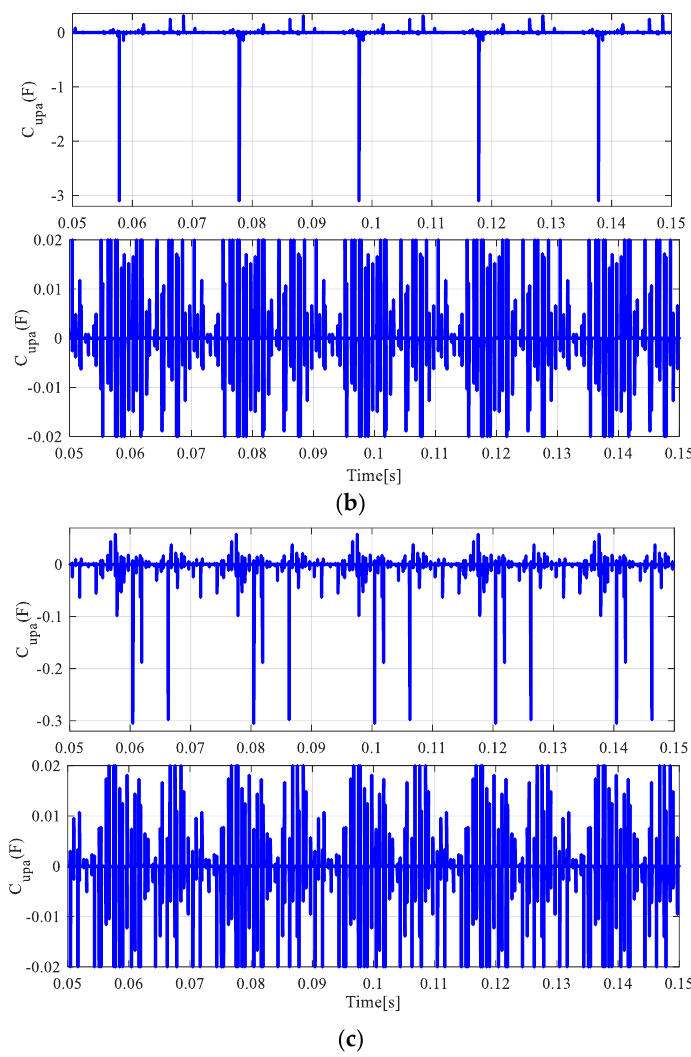
Figure 8. Equivalent capacitors for the upper arm of phase “a” : ( a ) first controller, ( b ) second controller, and ( c ) third controller.